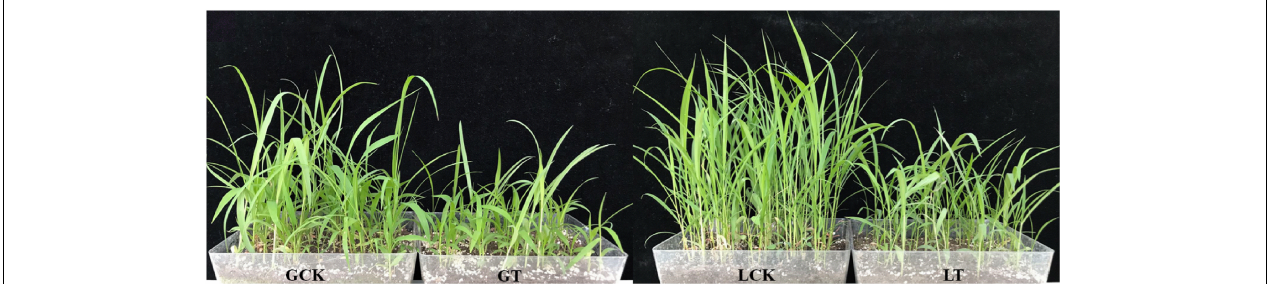
FIGURE 1 | Phenotypes of resistant/sensitive millet under atrazine stress at the seedling stage. GCK, GA2 (Gongai 2) treated with water; GT, GA2 treated with atrazine; LCK, LG31 (Longgu 31) treated with water; LT, LG31 treated with atrazine.